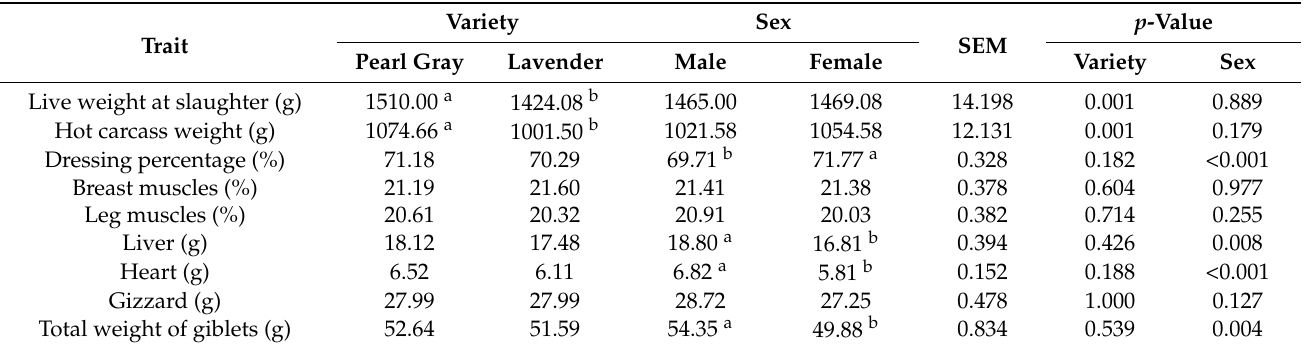
Table 2. Live weight at slaughter, dressing percentage, hot carcass weight, the total weight of giblets, and the proportions of breast and leg muscles in the carcasses of male and female guinea fowl of pearl gray and lavender varieties (means ± SEM).